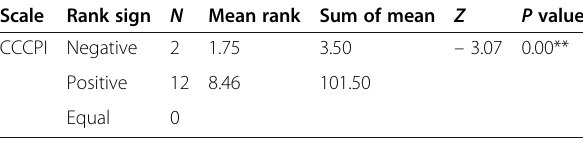
Table 4 Findings obtained from the Mann-Whitney U pre-test in the experimental and control groups.